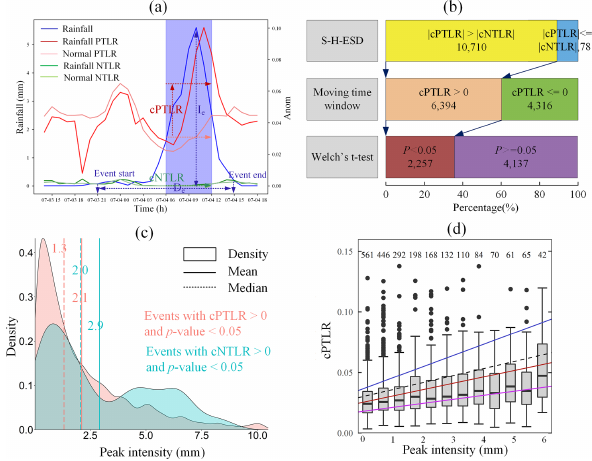
Figure 3. (a) The schematic definitions of the human activity anomaly associated with a specific rainfall event used in this study, where the x axis presents the “month–day hour”. (b) The relative proportions and numbers of the rainfall events with various cPTLR and cNTLR values (see the main text for definitions of cPTLR and cNTLR). (c) The probability density distribution curves of the events with significantly increased cPTLR/cNTLR. (d) Box plots by peak rainfall intensity groups per 0.5mm. Trend lines are shown for the ordinary least squares (OLS) regression (dashed black), 0.25 quantile (purple), median (red), and 0.75 quantile (blue) range. The numbers in Fig. 3d show the numbers of rainfall events with specific peak intensity as shown along the x axis.